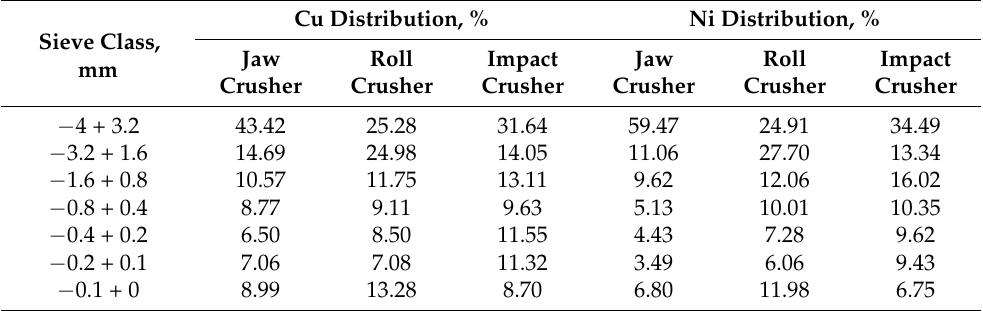
Table 9. Silica and calcium distribution in sieve classes for CNO for different types of crushers. Si Distribution, % Ca Distribution, % Sieve Class, Jaw Roll Impact Jaw Roll Impact mm Crusher Crusher Crusher Crusher Crusher Crusher − 4 + 3.2 − 1.6 + 0.8 6.90 − 0.8 + 0.4 − 0.4 + 0.2 − 0.2 +